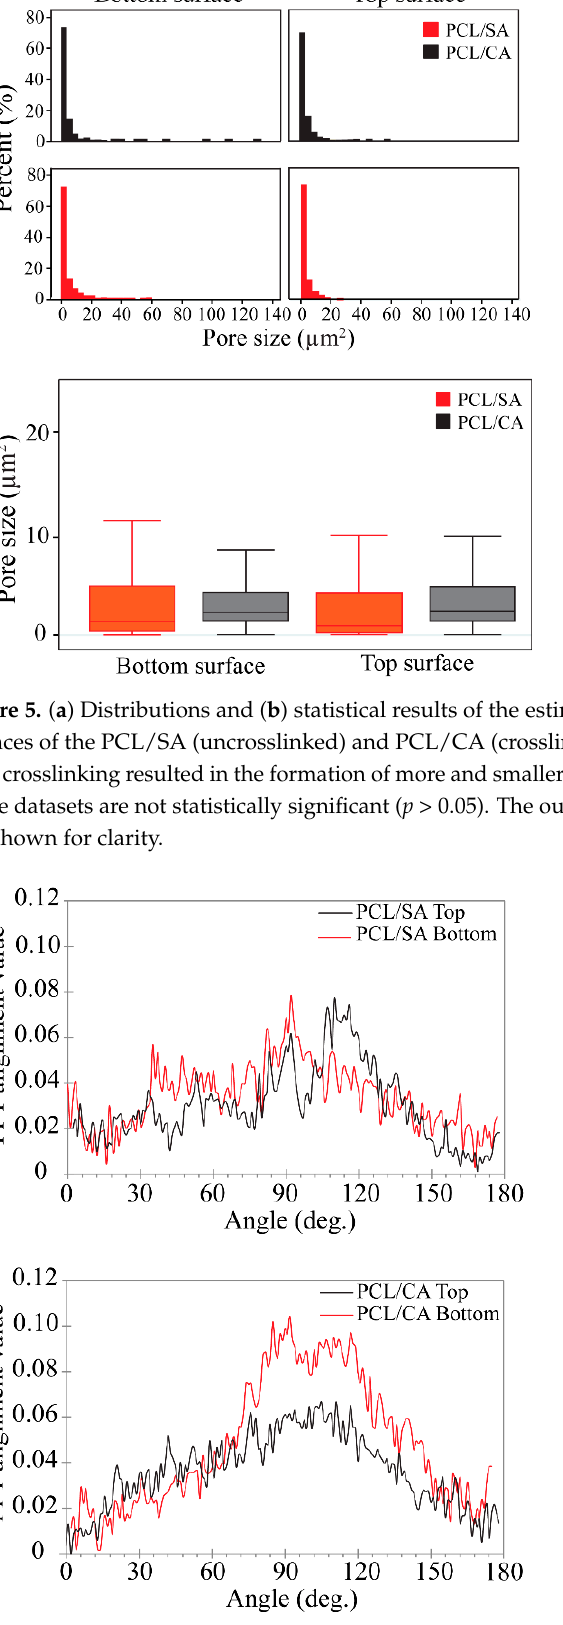
Figure 6. Representative distributions of the fiber alignment at the top and bottom surfaces of the ( a ) PCL/SA and ( b ) PCL/CA scaffolds.